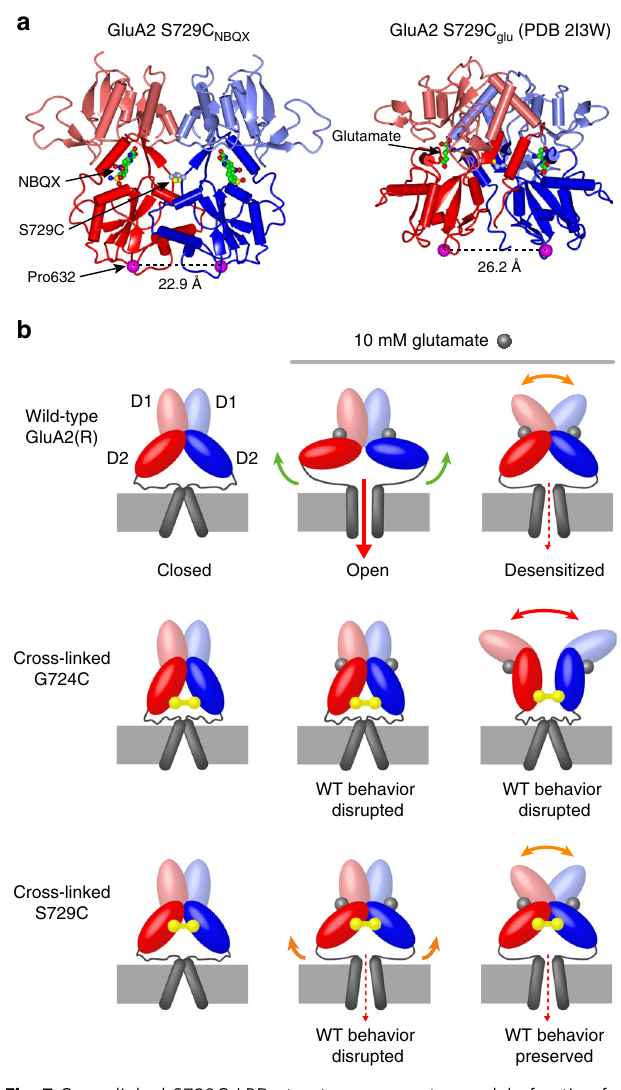
Fig. 7 Cross-linked S729C LBD structures suggest a model of gating for desensitized GluA2(R). a Left, crystal structure of the dimeric GluA2 S729C ligand-binding core in the presence of NBQX, with the upper (D1, pale) and lower (D2, dark) lobes of each monomer (red and blue) distinguished by shading. The structure is viewed perpendicular to the axis between the C α atoms of Pro632 (magenta spheres). Right, crystal structure of the GluA2 S729C ligand-binding core in the presence of glutamate (S729C glu ; PDB: 2I3W) 18 . The Pro632 separation seen in the presence of glutamate (right) is >3 Å greater than that seen with NBQX (left). b Cartoon representing possible conformations of the GluA2(R) LBD dimer and pore in our functional cross-linking recordings. Non- cross-linked GluA2(R) channels bind glutamate (gray spheres), closing the clamshell LBDs and opening the pore to the full open channel conductance. Desensitization does not fully close the pore. As determined in the presence of γ -2, cross-linking of the G724C mutant (yellow) does not allow the action of agonist binding to be communicated to the pore in any state, and disrupts the normal dimeric conformation of desensitized receptors. Cross-linking of the S729C mutant (yellow) is not compatible with the full open state, but the channel can adopt the normal desensitized conformation, meaning that (as with the non-cross-linked receptor) the pore is not